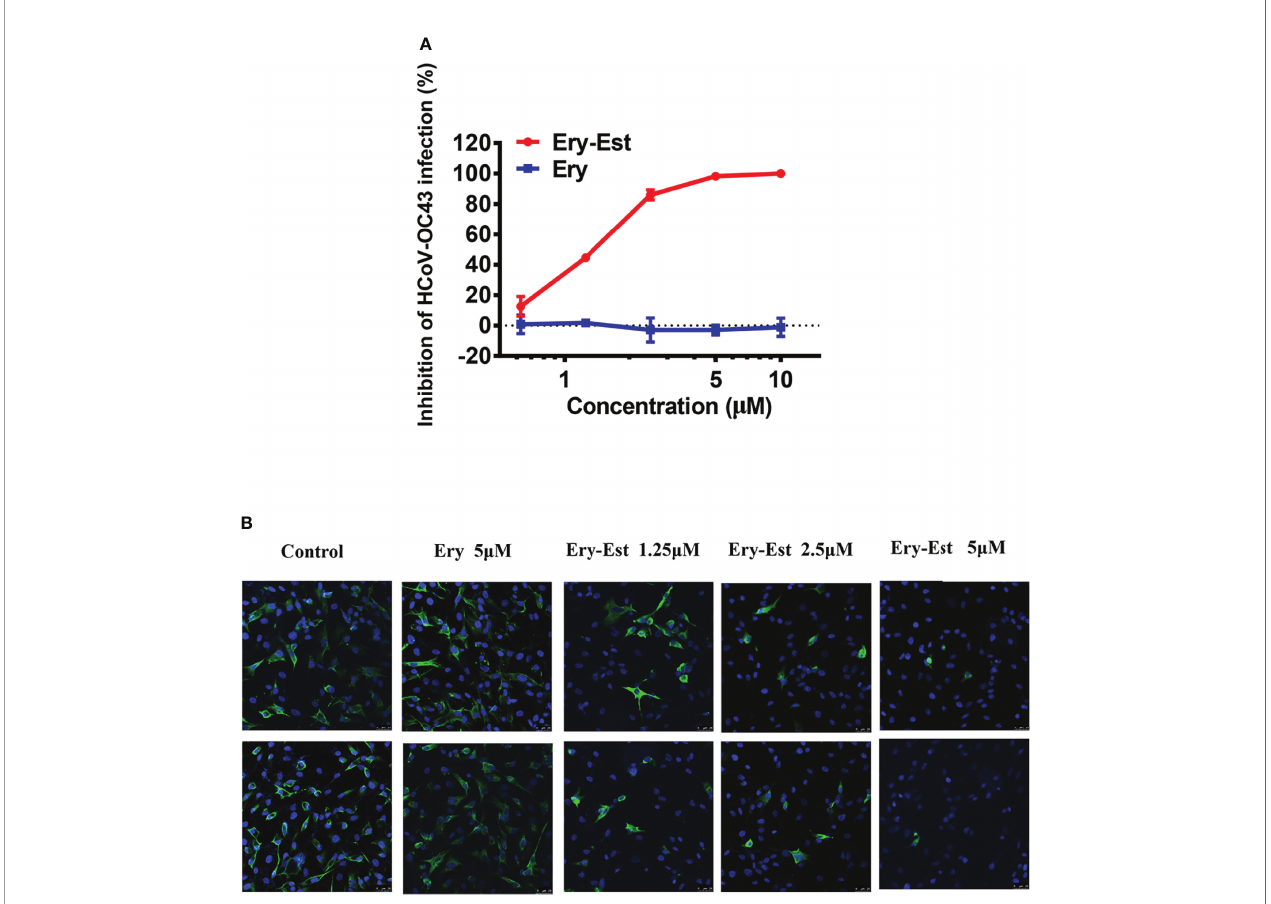
FIGURE 1 | The anti-HCoV-OC43 activity of Ery-Est. (A) Ery-Est suppressed HCoV-OC43 infection at a dose-dependent manner by plaque reduction assay using BHK-21 cells. The experiment was performed in triplicate, and the data were presented as means ± SD. (B) The anti-HCoV-OC43 effect of Ery-Est detected by immuno fl uorescence assay. HCoV-OC43 nucleoprotein was stained by anti-nucleoprotein mouse mAb and FITC-conjugated rabbit anti-mouse IgG (green); nuclei (blue) were stained by 4,6-diamidino-2-phenylindole